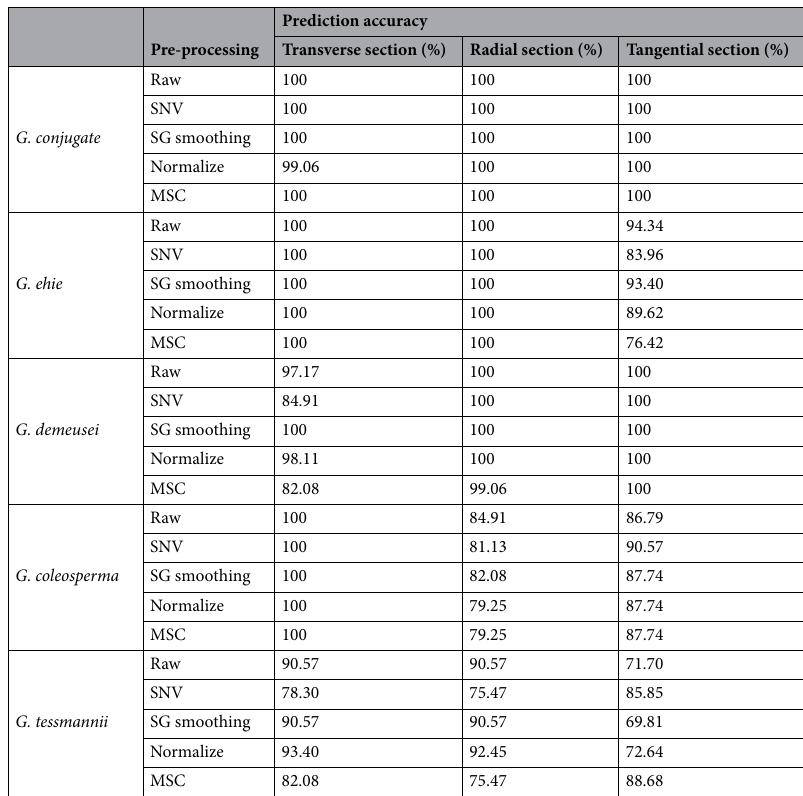
Table 1. Summary of the prediction results of PLS-DA model.